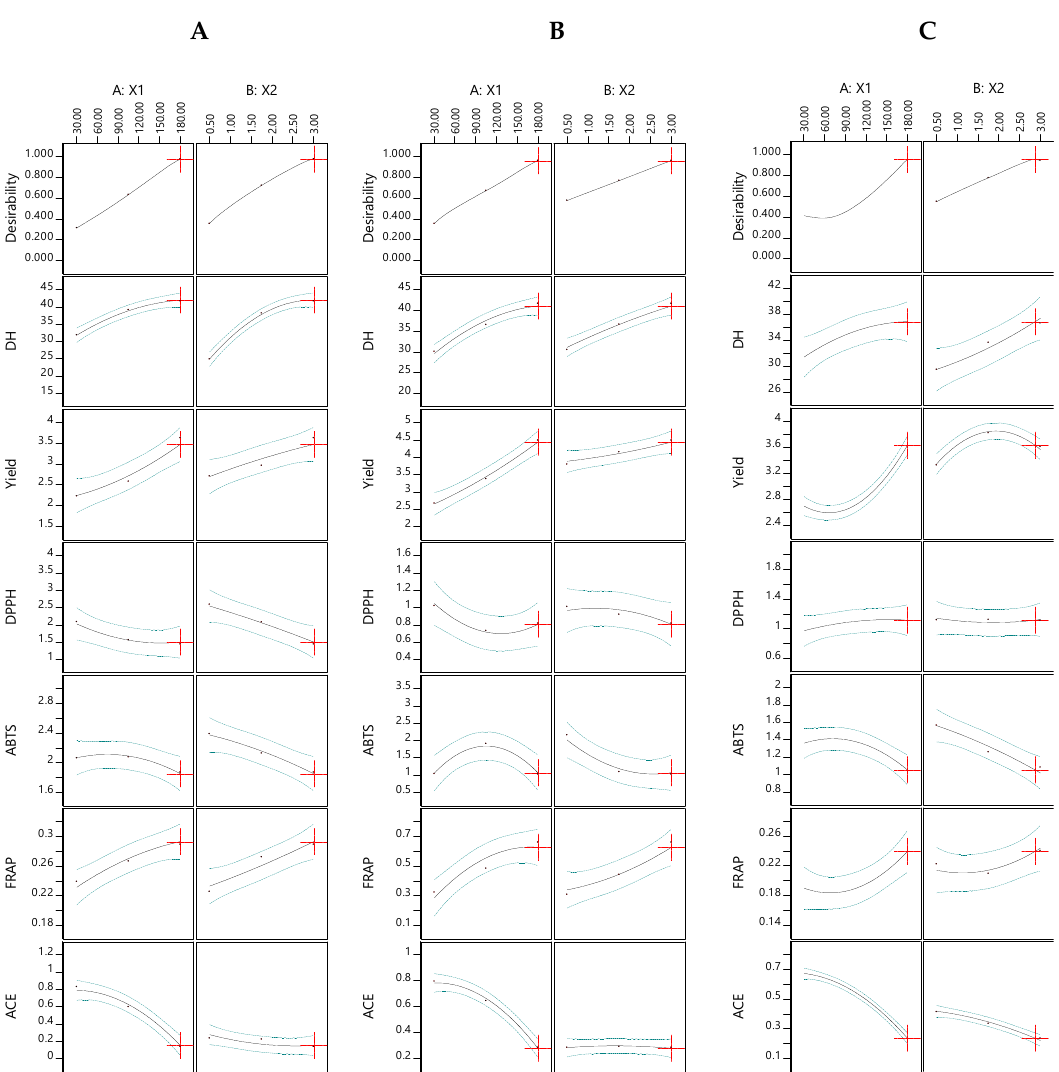
Figure 2. Main effect plot of hydrolysis time (X 1 ) and enzyme concentration (X 2 ) for DH, yield, DPPH radical scavenging activity, ABTS radical scavenging activity, FRAP assay and ACE inhibitory activity of TBH using Alcalase ( A ), Neutrae ( B ) and Flavourzyme ( C ).